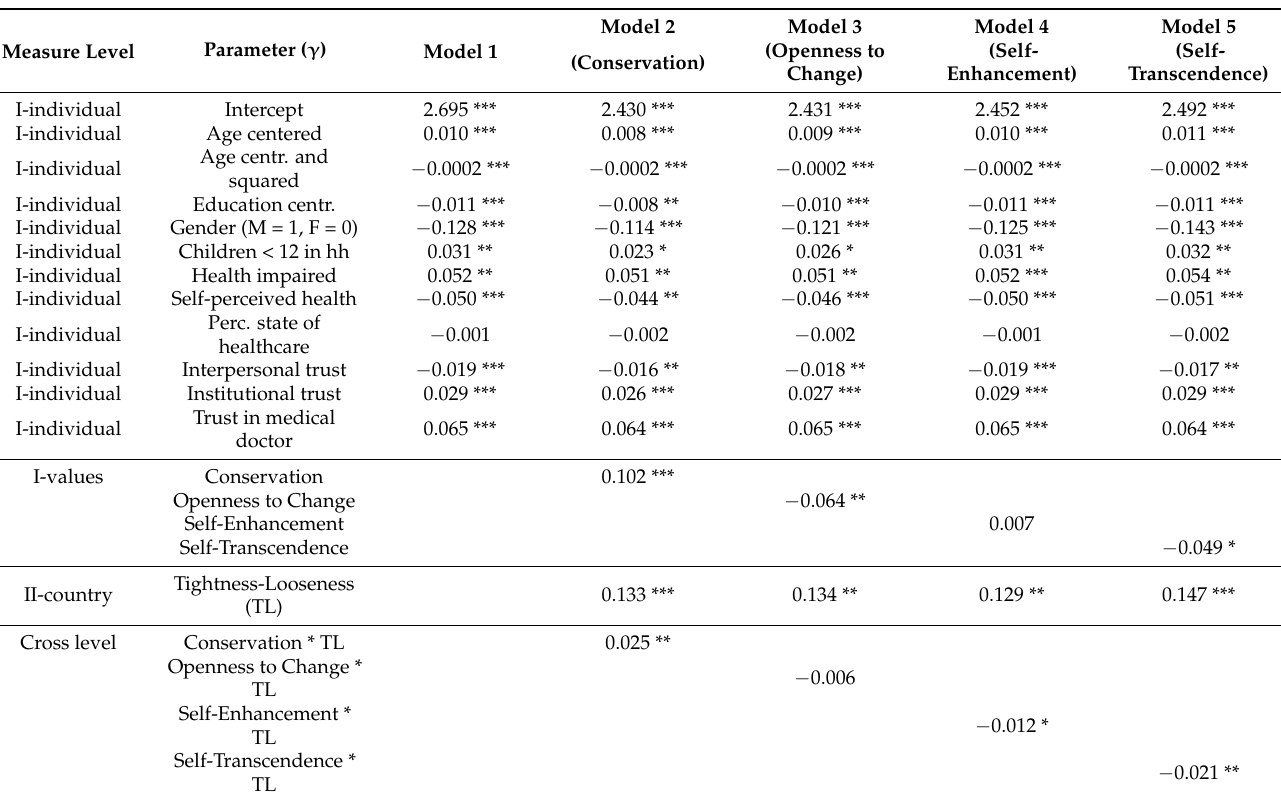
Table 2. Results multi-level models to predict preference for professional medical help in non-acute medical conditions, including variables at the individual level (indicated by I-) at the country level (indicated by II-) and cross-level interactions. Models 3–6 are nested in Model